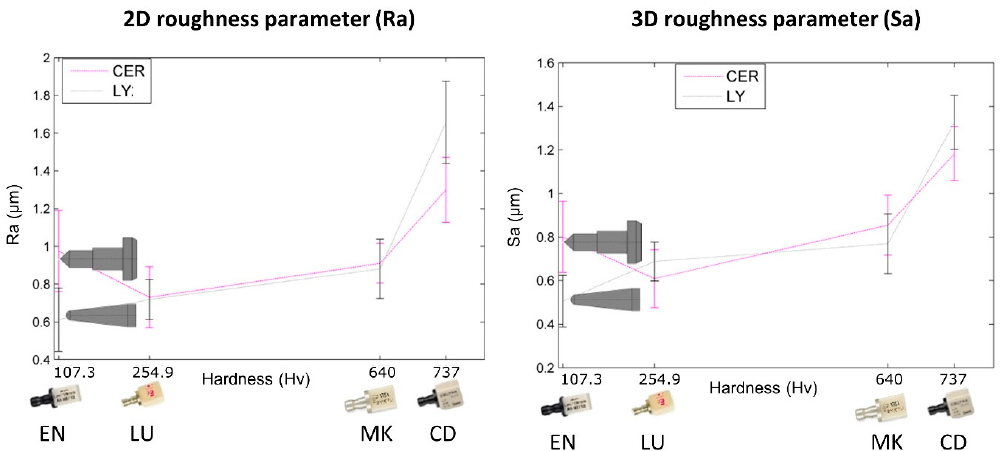
Figure 7. Correlations established between roughness and tool-biomaterial couples (vertical bars represent standard deviation).